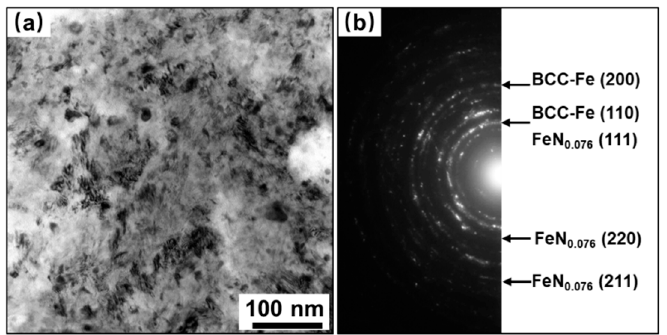
Figure 5. ( a ) TEM image and ( b ) the corresponding SAED of the surface of the M50 Sample D-N nitrided at 500 °C for 4 h.